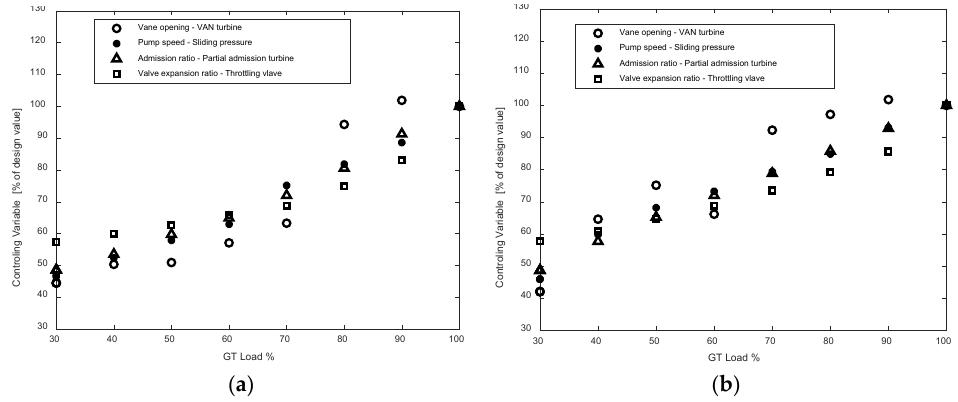
Figure 8. Control manipulating variables in different control strategies: ( a ) case A; ( b ) case B. Off-design heat transfer coefficient and pressure loss are illustrated in Figure 9. As lower mass flow rate and lowest Reynolds number are seen in part-load, the pressure loss and heat transfer coefficient decrease in off-design conditions. Having a lower Reynolds number in fully turbulent flows through the heat exchanger tubes degrades the mixing rate in the flow. It is known that mixing and flow eddies are the main agents for heat transfer in a turbulent pipe